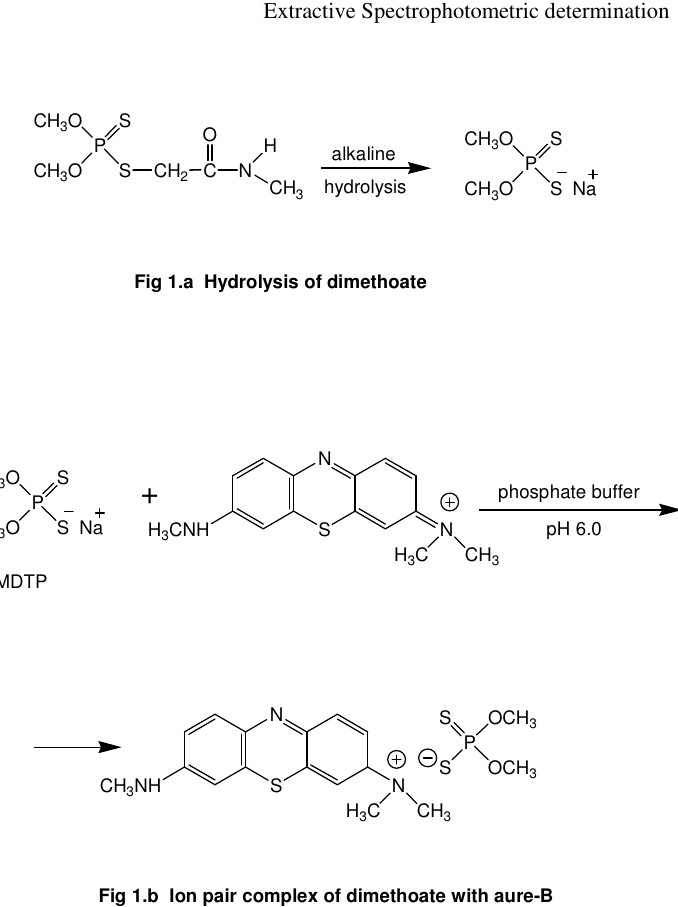
Table 1 Determination of dimethoate in insecticidal formulations using azure-B as complexing agent